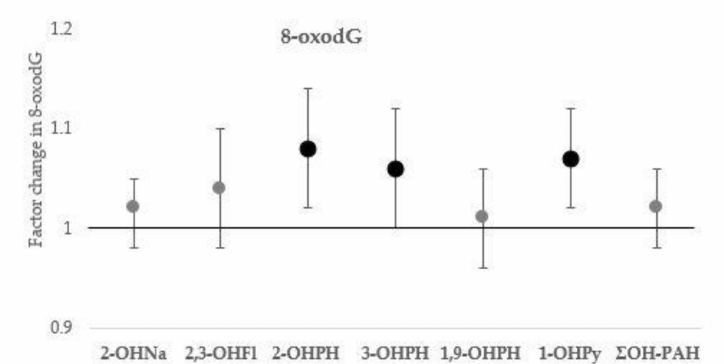
Figure 3. Associations of urinary OH-PAHs concentration with urinary 8-oxodG. Effect estimates are presented with their 95% confidence interval (95% CI) as the factor change in 8-oxodG for a doubling in OH-PAH concentration. Models adjusted for urinary specific gravity, sex, age, BMI, household socio-economic status, season of sampling, smoking, and residential exposure to envi- ronmental tobacco smoke. Significant associations ( p -value ≤ 0.05) are marked in bold. Abbrevi- ations: OH-PAHs—hydroxylated polycyclic aromatic hydrocarbon;